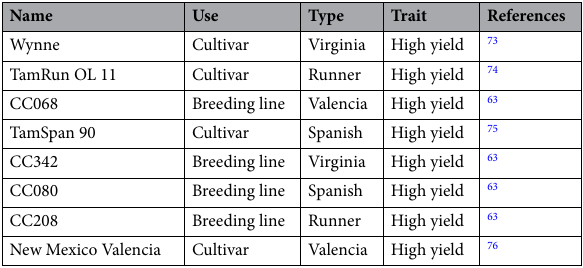
Table 2. Genotypes planted in study 2 for validation of study 1 model.